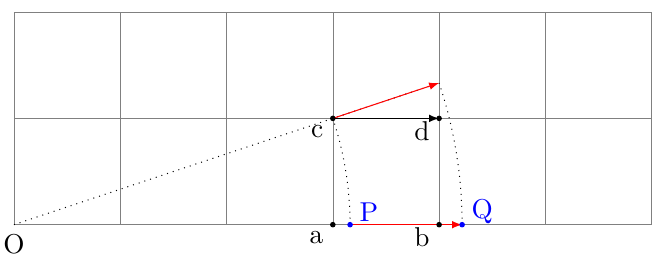
Figure 29 . The link variable required is the one that maps c → d . This can be calculated from the upper red link, which is equal to the lower one by cylindrical symmetry. The lower red link is given by θ = − θ + θ + θ where interpolation is used to approximate the mapping from PQ aP ab bQ a → P and b → Q